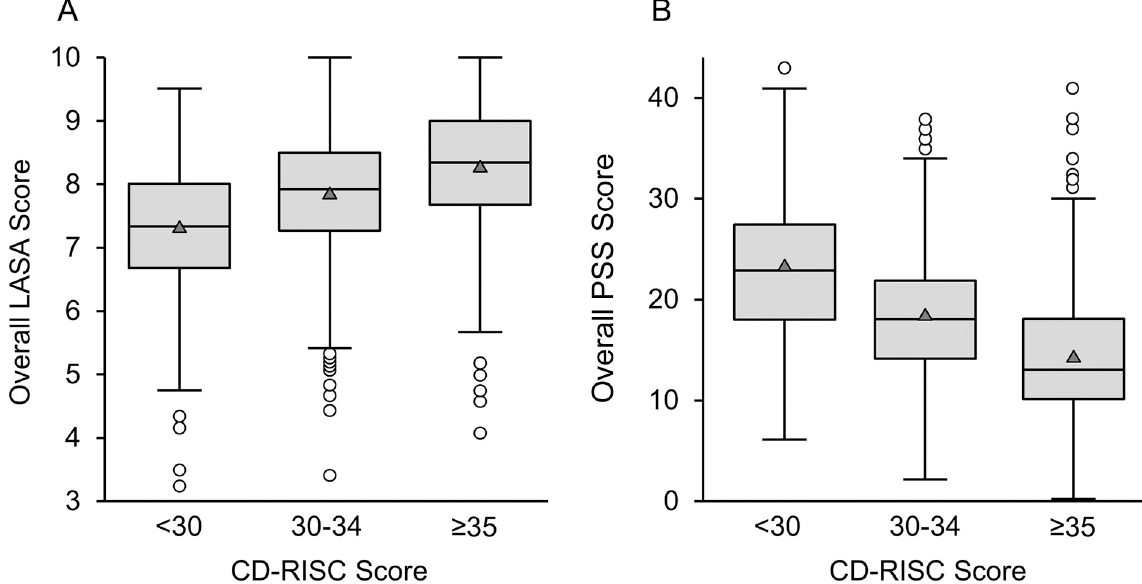
Fig 2. Box-and-Whisker Plots of LASA and PSS scores, Stratified by Resilience Levels. Resilience groups were defined by the CD-RISC score. Lower resilience was defined as a score < 30; medium resilience, 30–34; higher resilience, � 35. Boxes show the median (middle horizontal line), interquartile range (25 th percentile [Q1] and 75 th percentile [Q3]: lower and upper edges of box), and range; the whiskers (dashed lines) extend from the outer edges of the box to the most extreme point within a distance equal to 1.5 × (Q3-Q1); any observations extending beyond that distance are shown as individual points in the figure. A, Overall LASA score ( P < .001 for all pairwise comparisons). B, PSS Score ( P < .001 for all pairwise comparisons). CD-RISC indicates Connor-Davidson Resilience Scale; LASA, Linear Analogue Self-Assessment; PSS, Perceived Stress Scale.